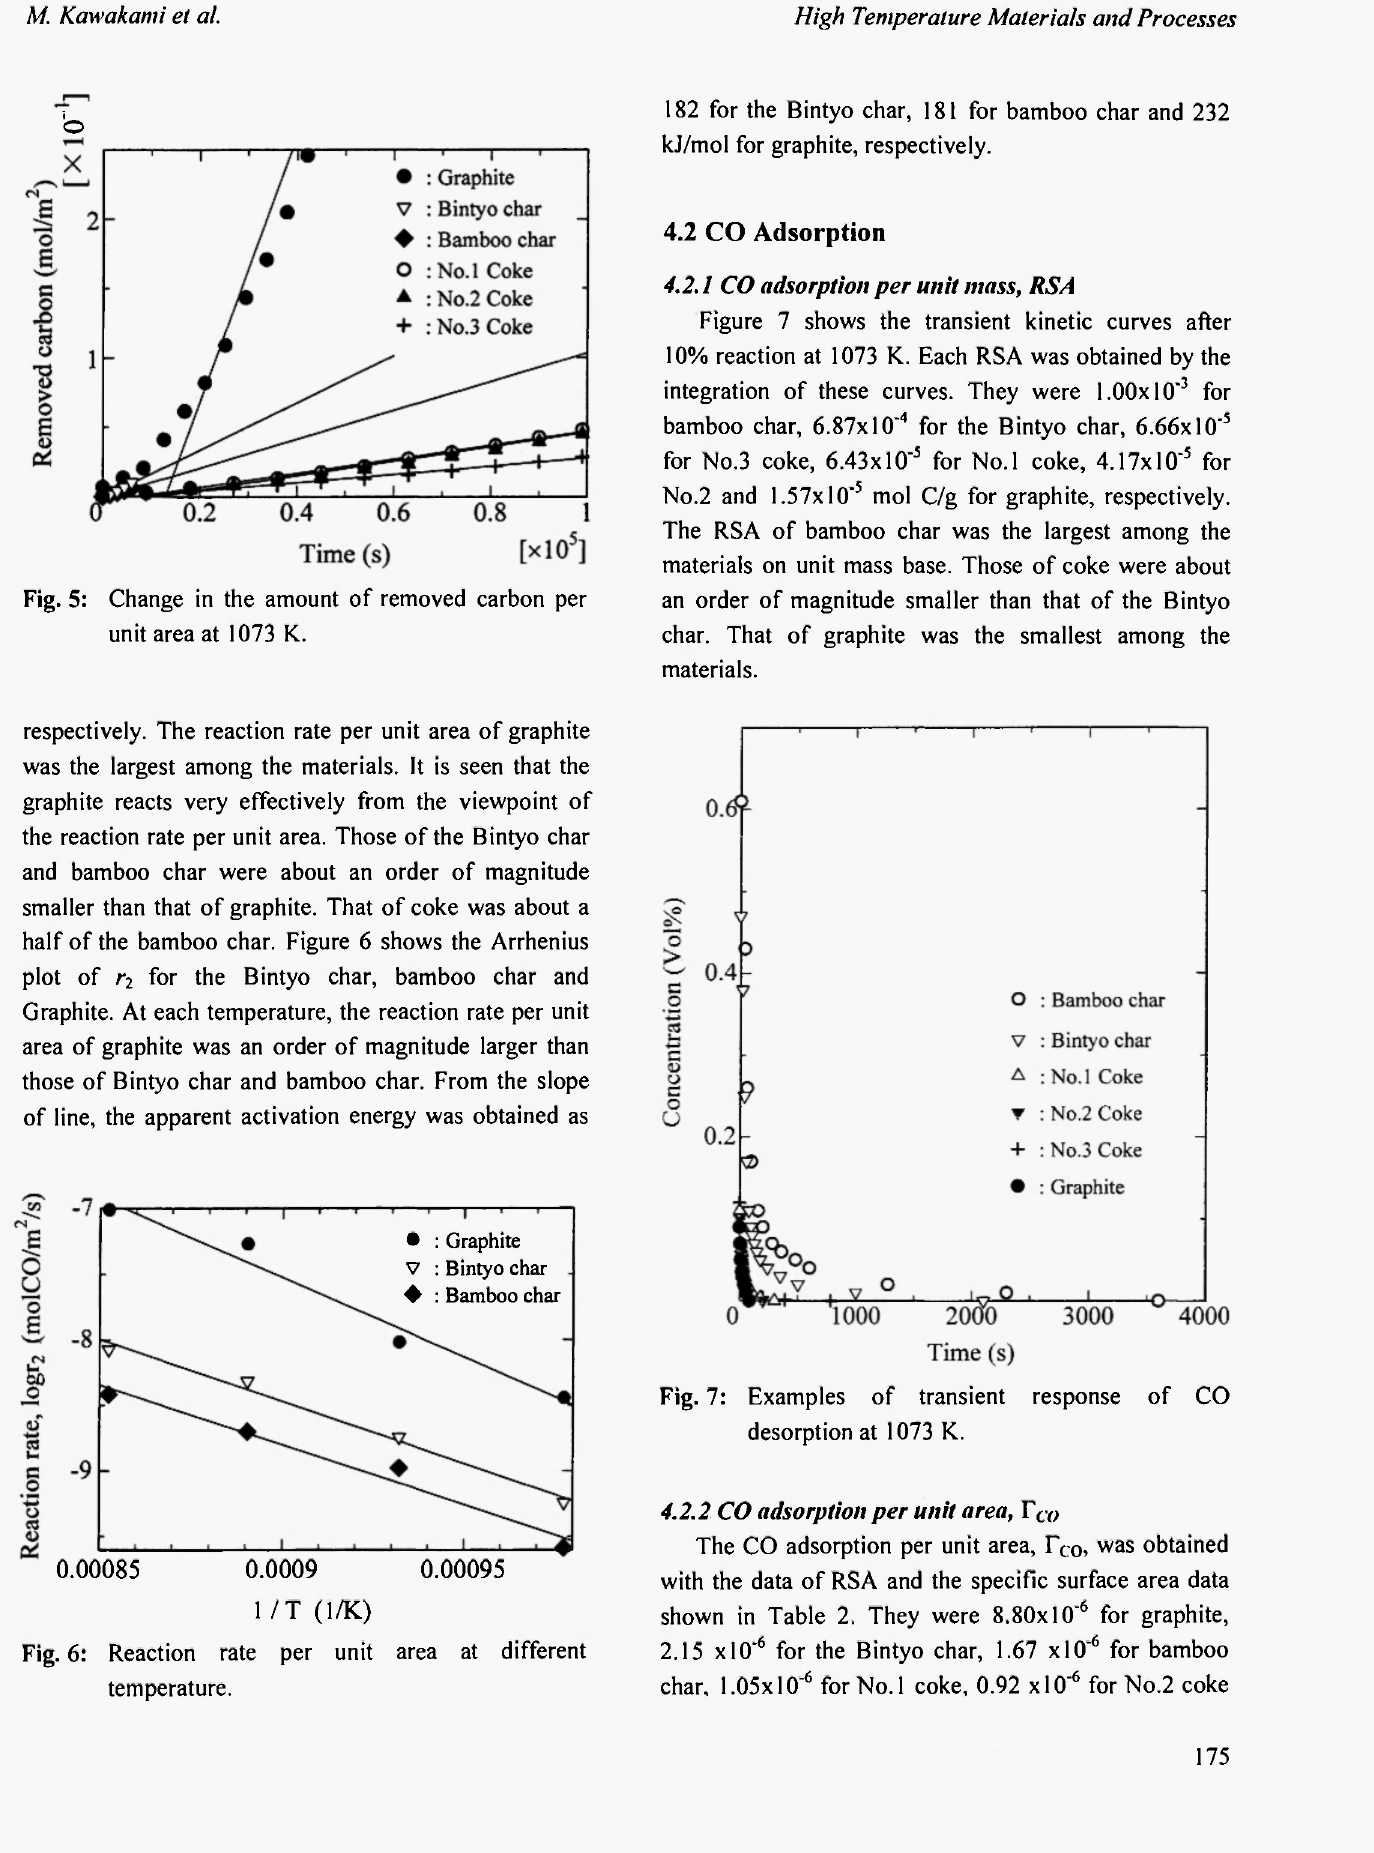
Fig. 5: Change in the amount of removed carbon per unit area at 1073 K.